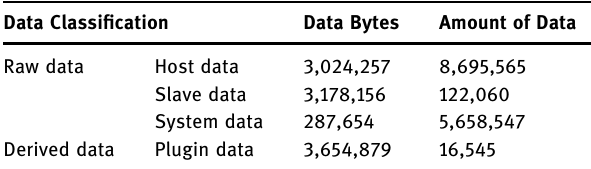
Figure 5: Security risk model.